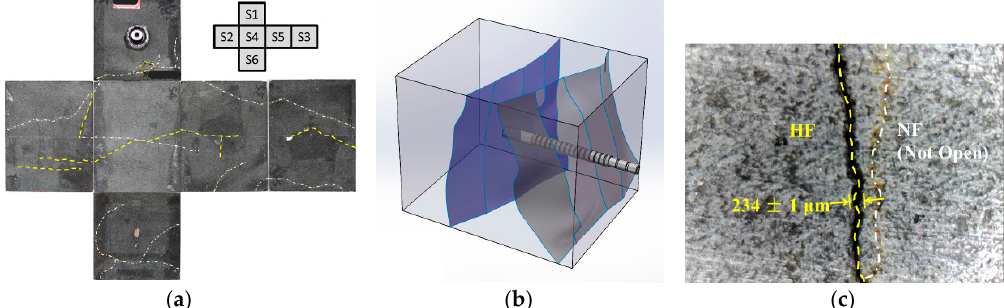
Figure 7. Fracture details of specimen No. 3: ( a ) Distribution on the surface, ( b ) internal reconstruction, and ( c ) microscope image.